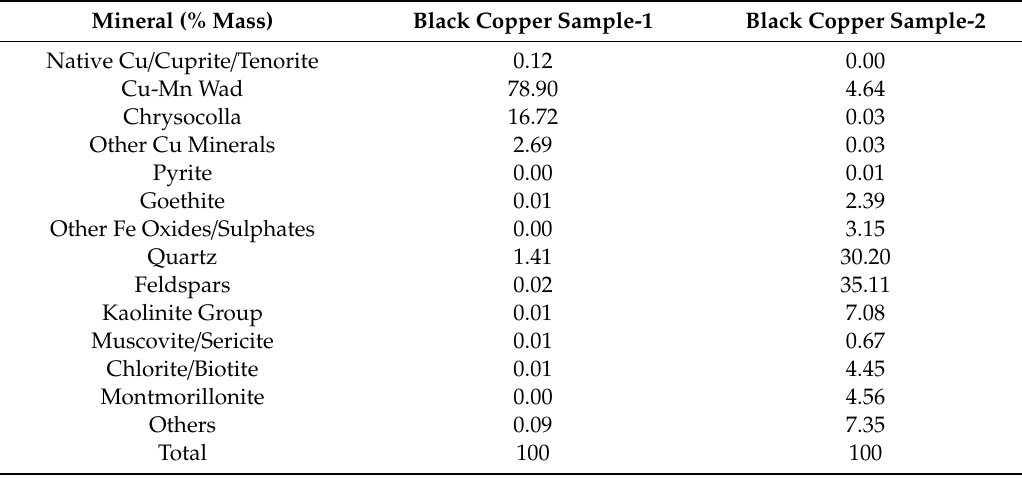
Table 2. The mineralogical composition of the black copper samples as determined by QEMSCAN.